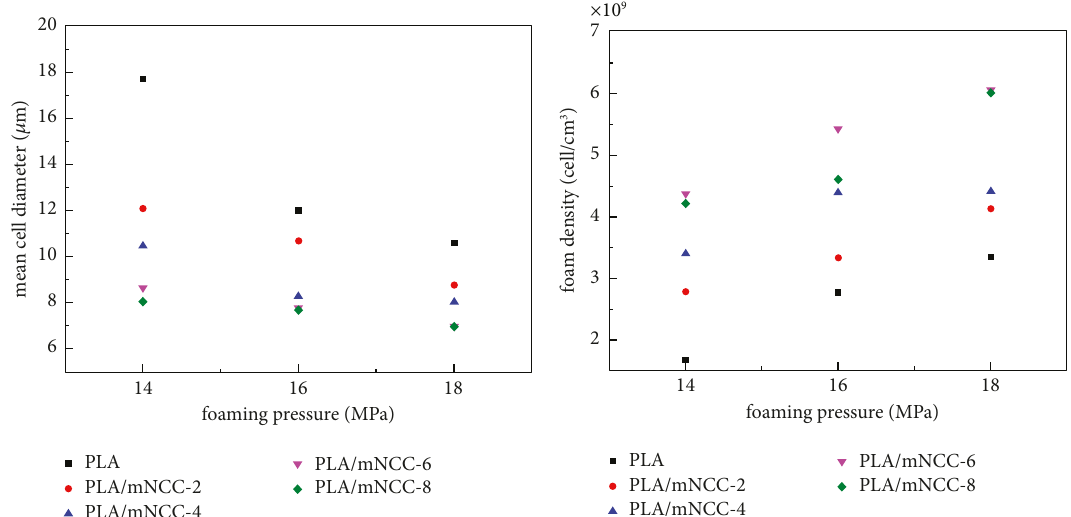
Figure 15: Average cell diameter and cell density of foaming nanocomposite under different pressure and nanoparticle content (110 ° C, 2h).